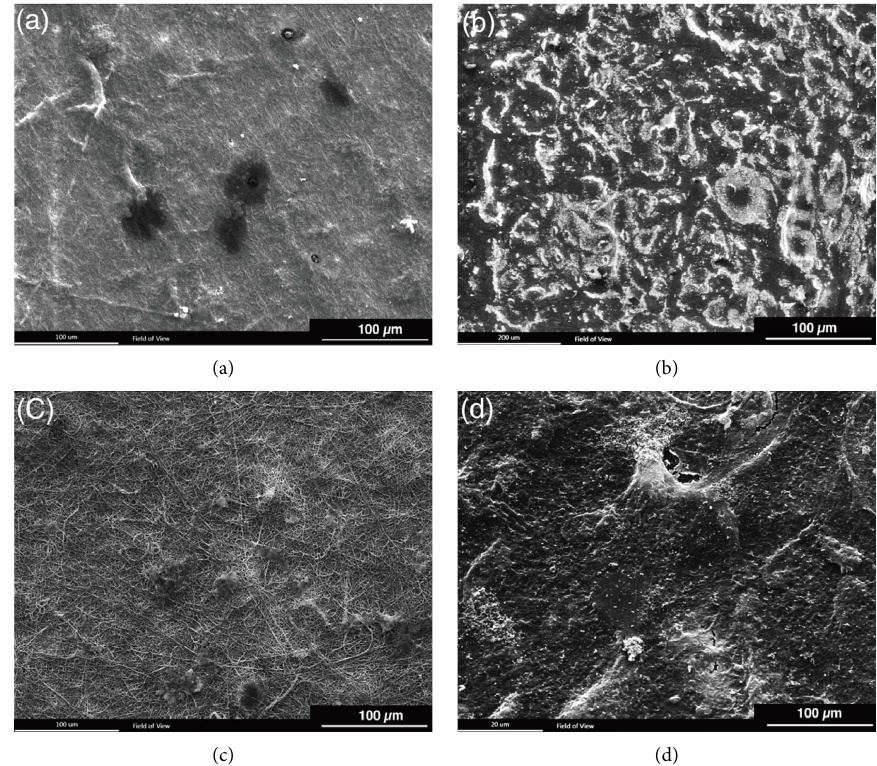
Figure 8: Morphology of the ARPE cells on scafolds, (a) A-30 after 1 day of culture, (b) A-30 after 7 days of culture, (c) R-30 after 1day of culture, and (d) R-30 after 7days of